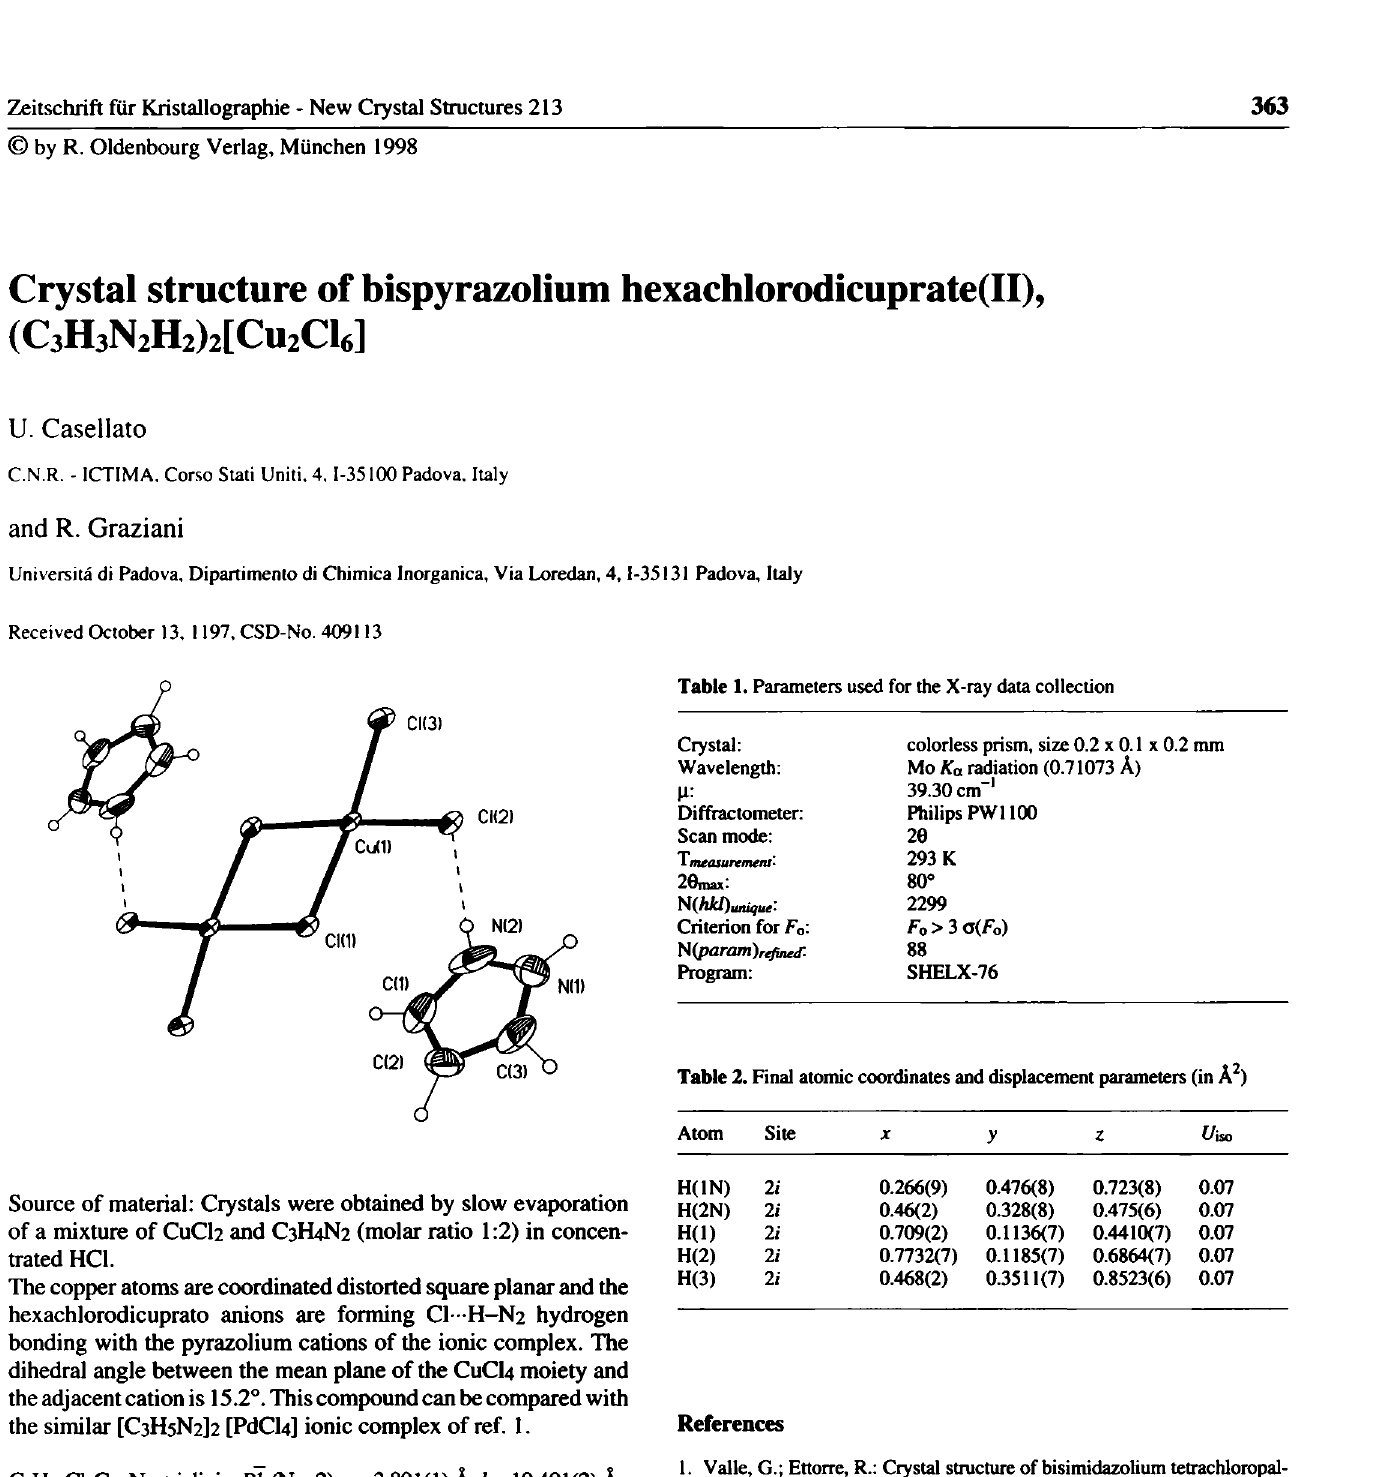
Table 3. Final atomic coordinates and displacement parameters (in À^)